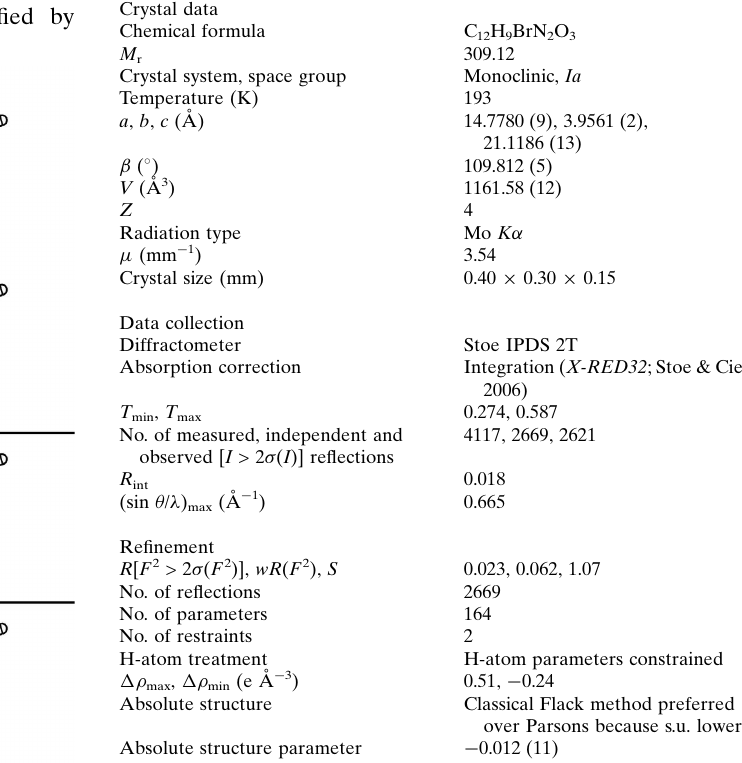
Table 2 Experimental